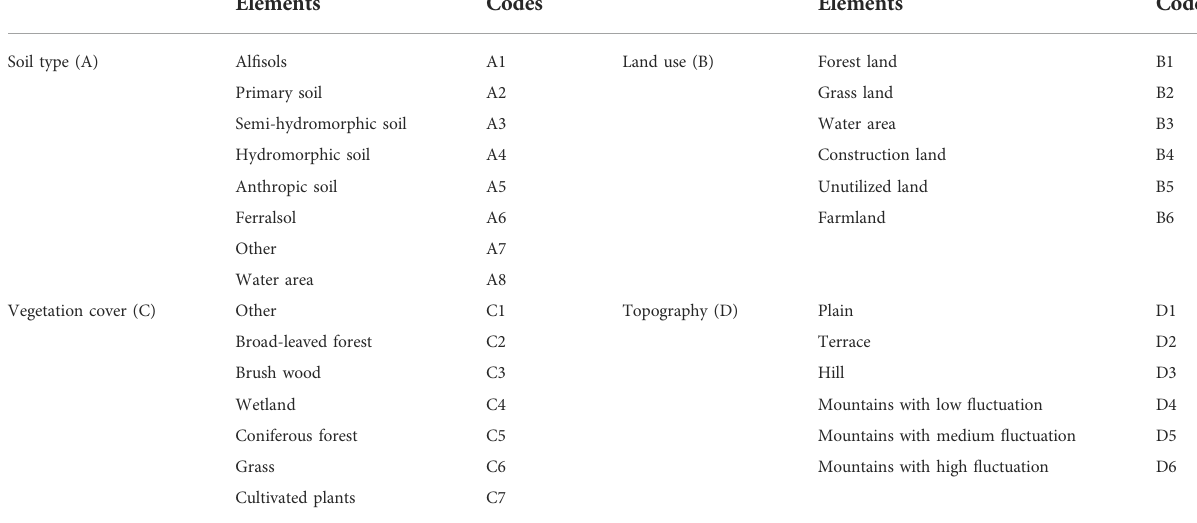
TABLE 1 Classi fi cation and coding of different landscape